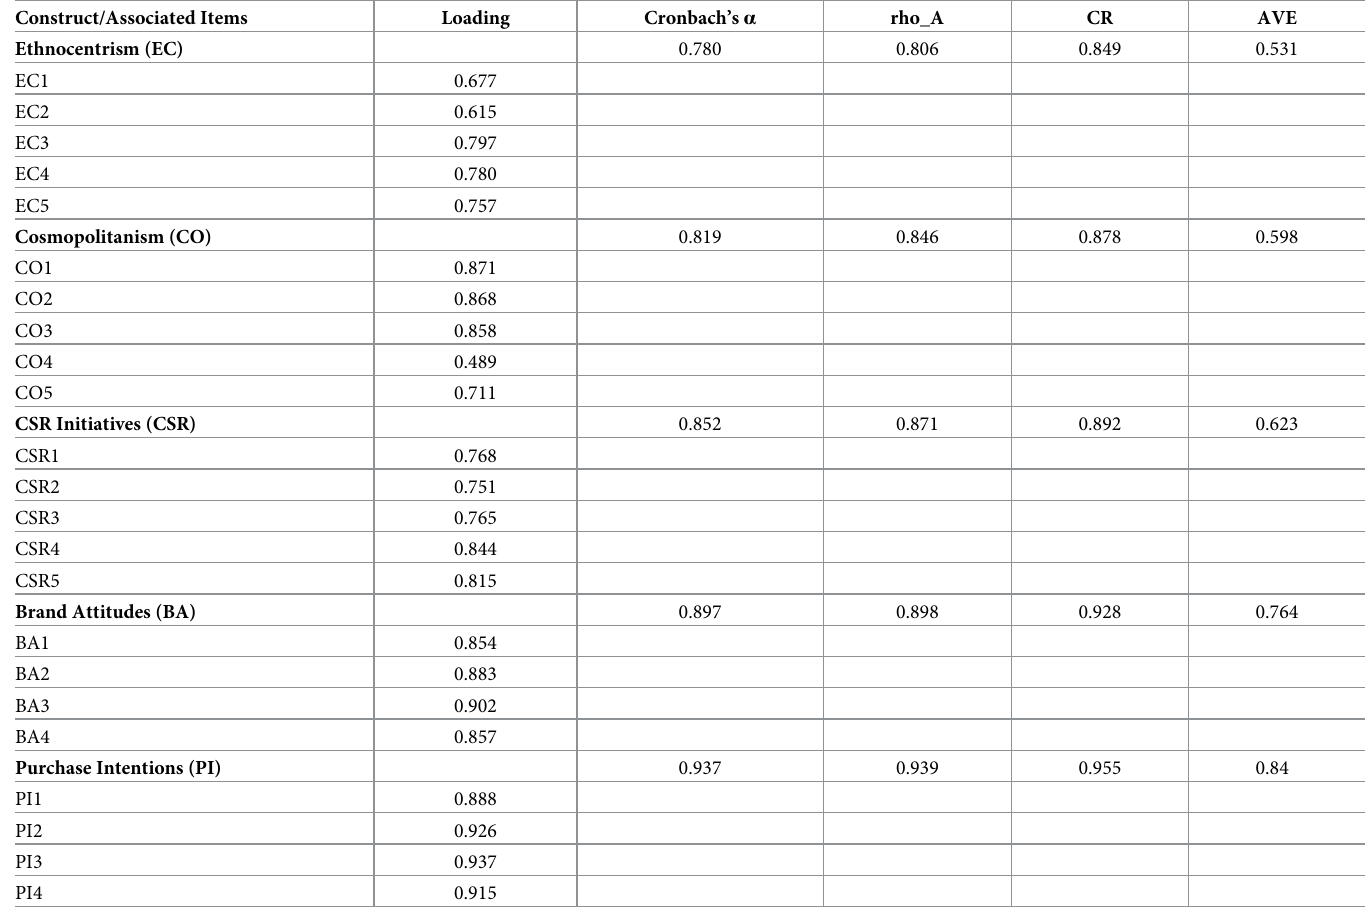
Table 3. Assessment results of the measurement